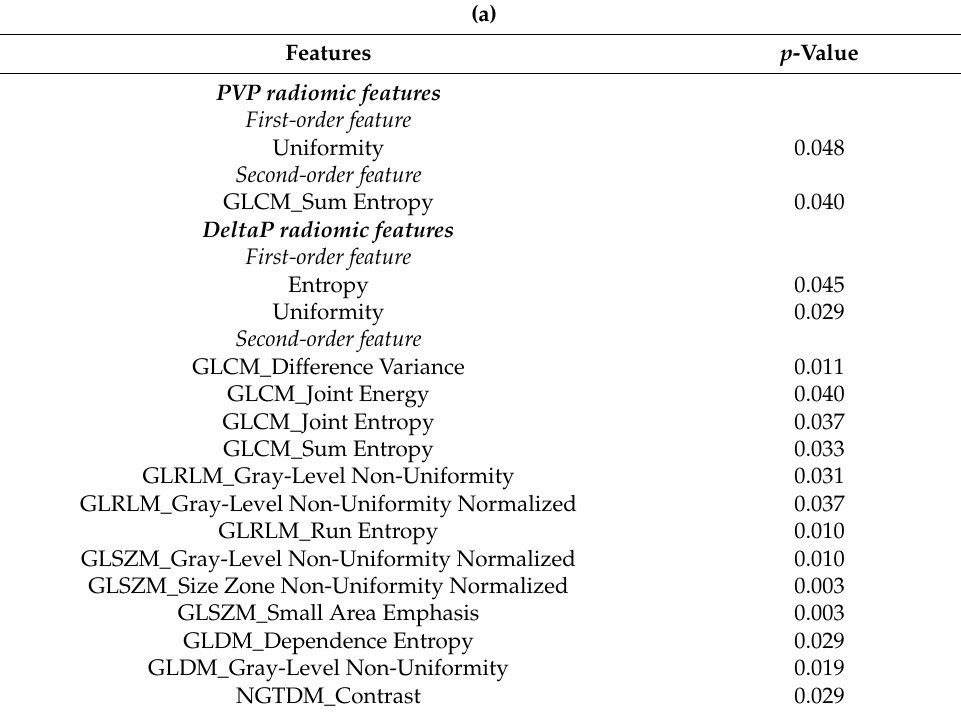
Table 3. (a) A list of statistically significant features identified from two-sided independent Mann– Whitney U test for 3-month treatment response assessment. (b) A list of statistically significant features identified from two-sided independent Mann–Whitney U test for 6-month treatment re- sponse